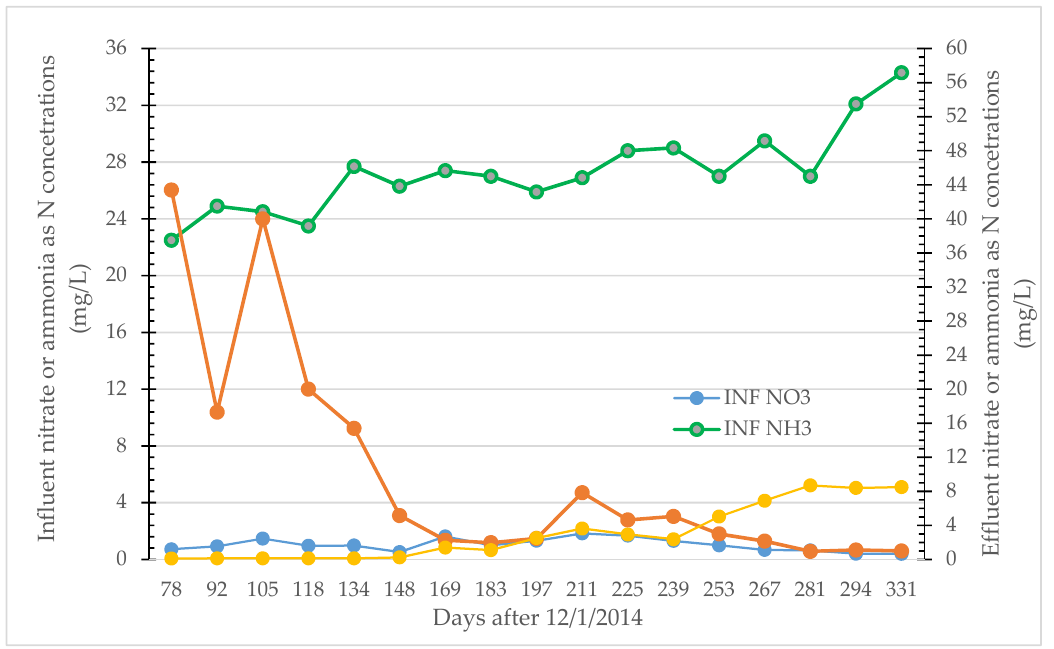
Figure 3. Influent and effluent nitrogen concentrations in the Martinez linear-channel reactor during the latter ten months of the project.